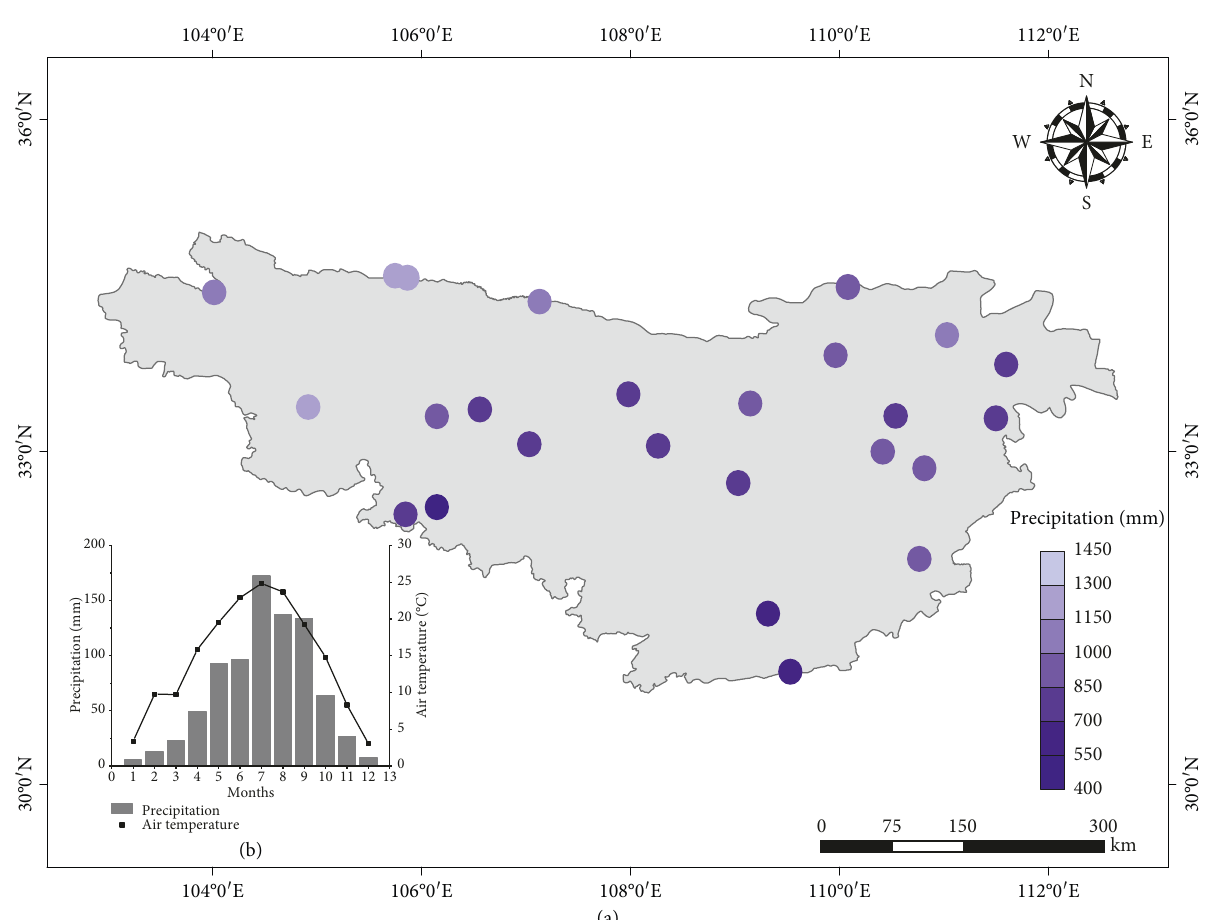
Figure 2: (a) The spatial distribution of annual rainfall; (b) the time distribution of monthly rainfall and air temperature throughout the year over the Qinling-Daba Mountains, China (Figure 2 is reproduced from Wang et al. [27], under the Creative Commons Attribution License/ public